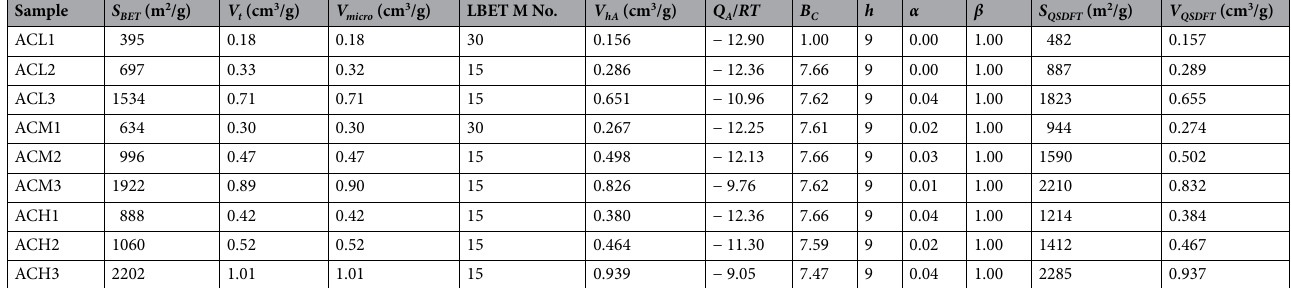
Table 1. Parameters characterizing the microporous structure of the activated carbons developed by chemical activation of Pine cones with KOH, obtained with different impregnation ratios and process temperatures, based on the analysis of N 2 adsorption isotherms using the BET, DR, LBET, and DFT methods. Where: S BET —the specific surface area; V micro —the micropore volume; V t —the total pore volume; V hA —the volume of the first adsorbed layer, Q A / RT —the dimensionless energy parameter for the first adsorbed layer; B C —the dimensionless energy parameter for the higher adsorbed layers; α —the geometrical parameter of the porous structure determining the height of the adsorbate molecule clusters; β —the geometrical parameter of the porous structure determining the width of the adsorbate molecule clusters; h —the surface heterogeneity parameter; S